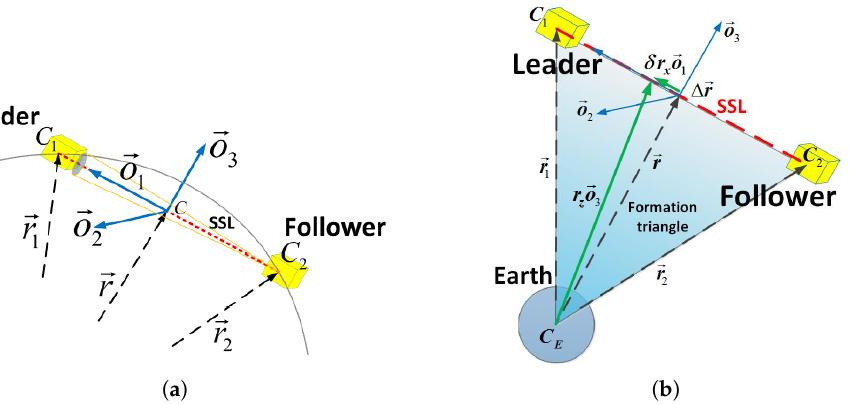
Figure 1. The Formation Local Reference Frame (FLOF) and the triangle virtual structure. ( a ) FLOF coordinated axes. ( b ) Formation triangle virtual